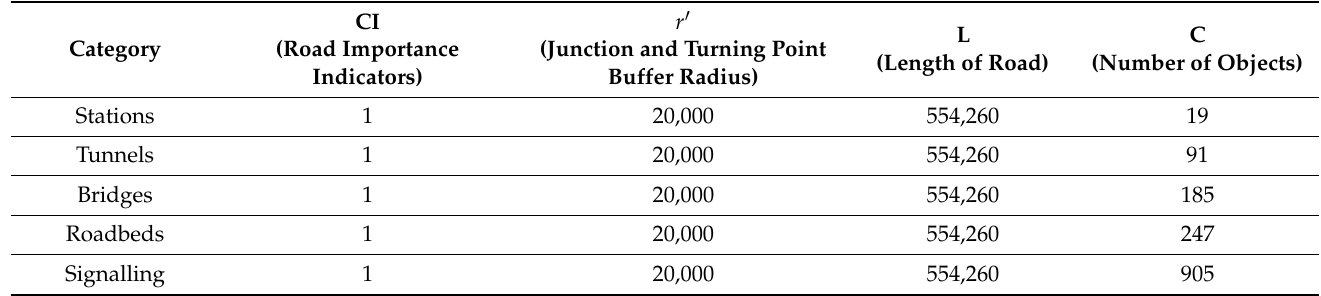
Table 3. Five types of object data parameters.